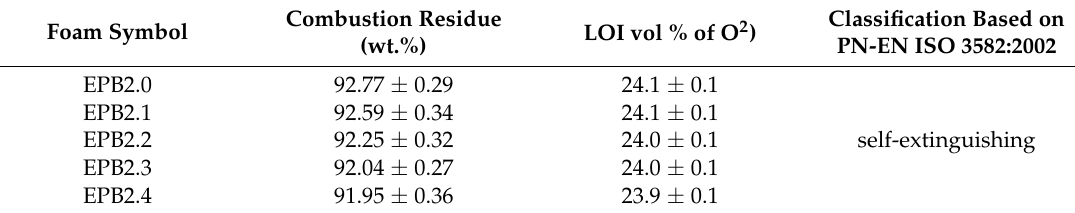
Table 5. Flammability tests of RPU/PIR foams with biopolyol.